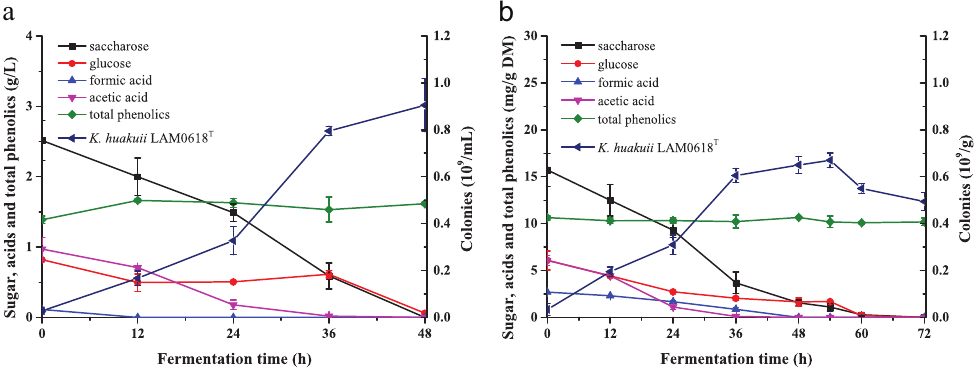
Figure 4. Detoxification curves by K. huakuii LAM0618 T using NH 3 /H 2 O 2 -pretreated but unwashed corn stover as substrate ( a ) through liquid cultivation with 8% ( w / w ) substrate loading or ( b ) through solid cultivation with 30% ( w / w ) substrate loading. All experiments were performed in duplicate and results are presented as mean ± SD. Error bars indicate